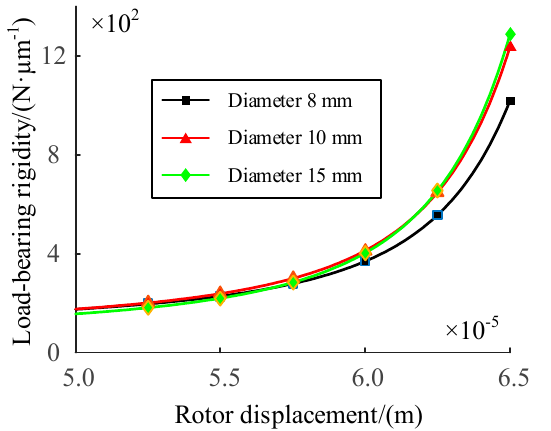
Figure 7. Curves of bearing stiffness and rotor displacement system under different bearing cavity diameters.